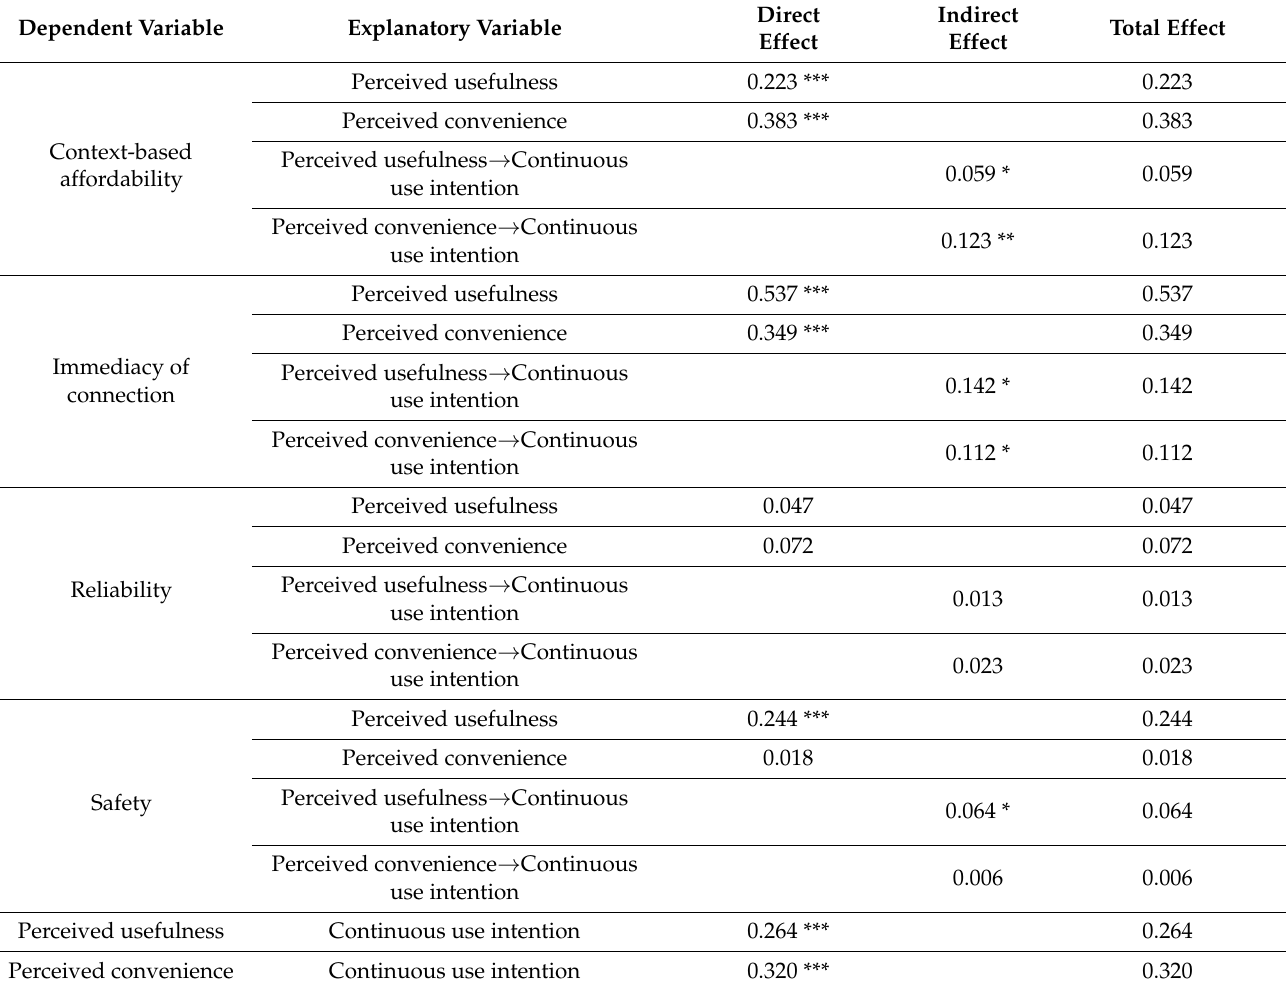
Table 7. Results of mediated